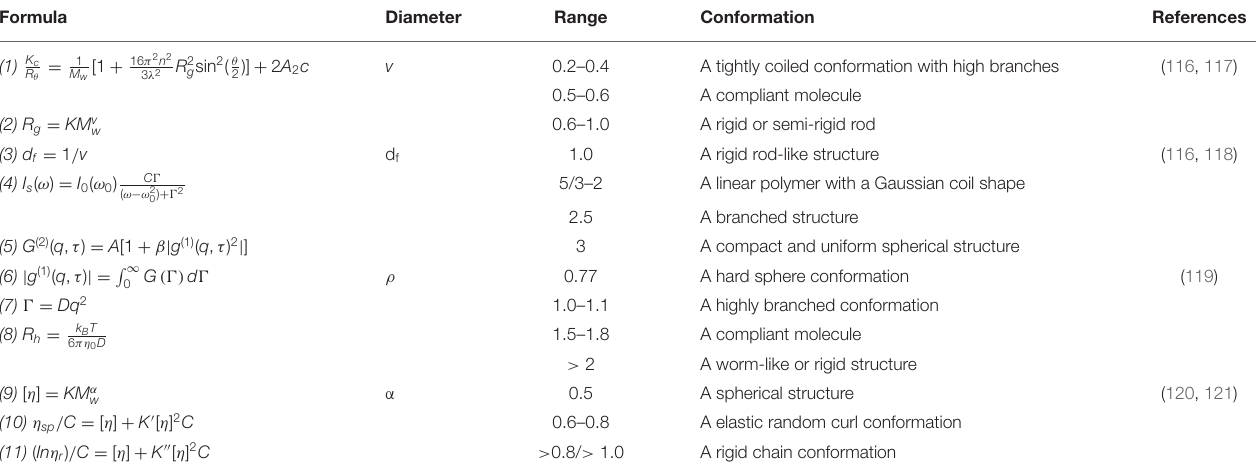
TABLE 5 | The parameters, calculation formulas, and the chain conformation information reflected by them.